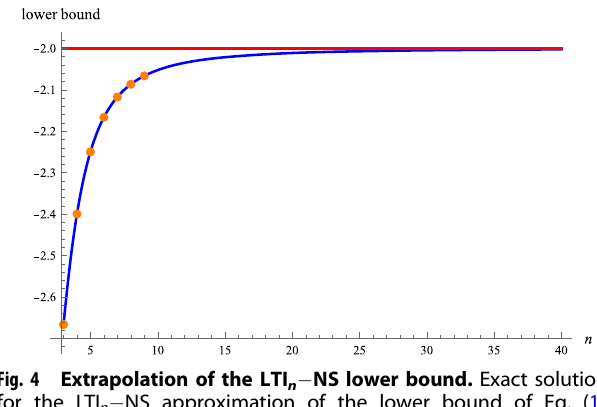
Fig. 4 Extrapolation of the LTI n − NS lower bound. Exact solutions for the LTI n − NS approximation of the lower bound of Eq. (15) (orange dots), the fi tted function (16) (blue line) when 3 ≤ n ≤ 40, and the classical bound (red line).